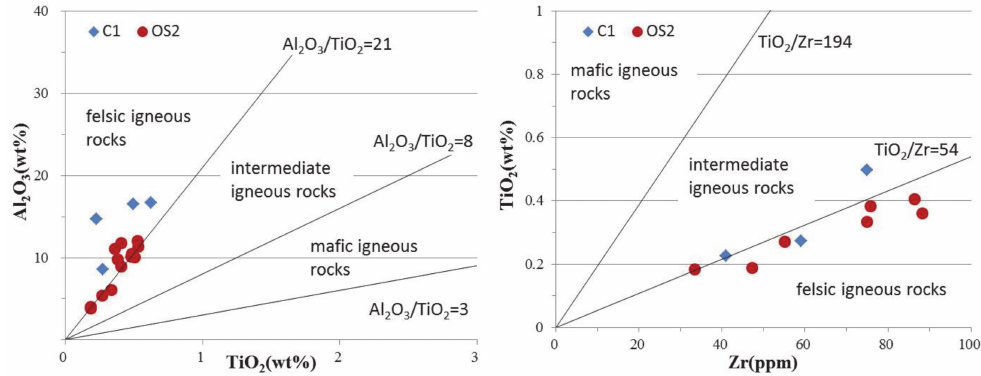
Figure 10. Al 2 O 3 (wt%) versus TiO 2 (wt%) and TiO 2 (wt%) versus Zr (ppm) diagrams for the C1 coals and OS2 oil shales.